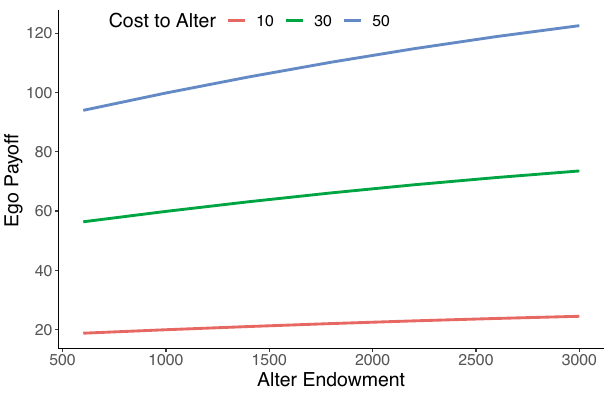
Figure 1. Illustration of our wealth productivity manipulation. As alters endowment increases, so does the amount ego receives from varying levels of alter’s cooperation (10, 30, and